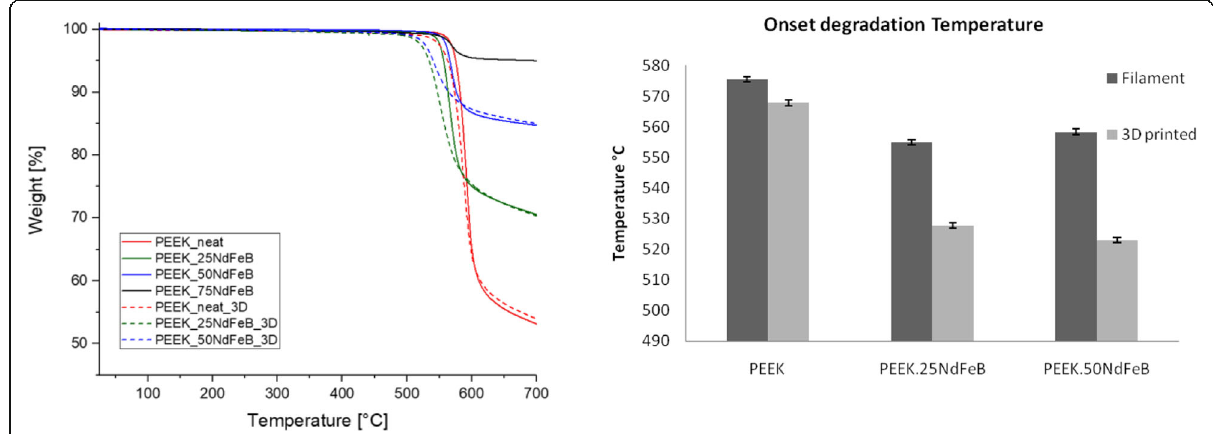
Fig. 10 TGA curves in Nitrogen for all PEEK NdFeB composites: continuous line are referred to filaments, dashed line are referred to 3D printed samples; right figure highlights the differences on the onset temperature